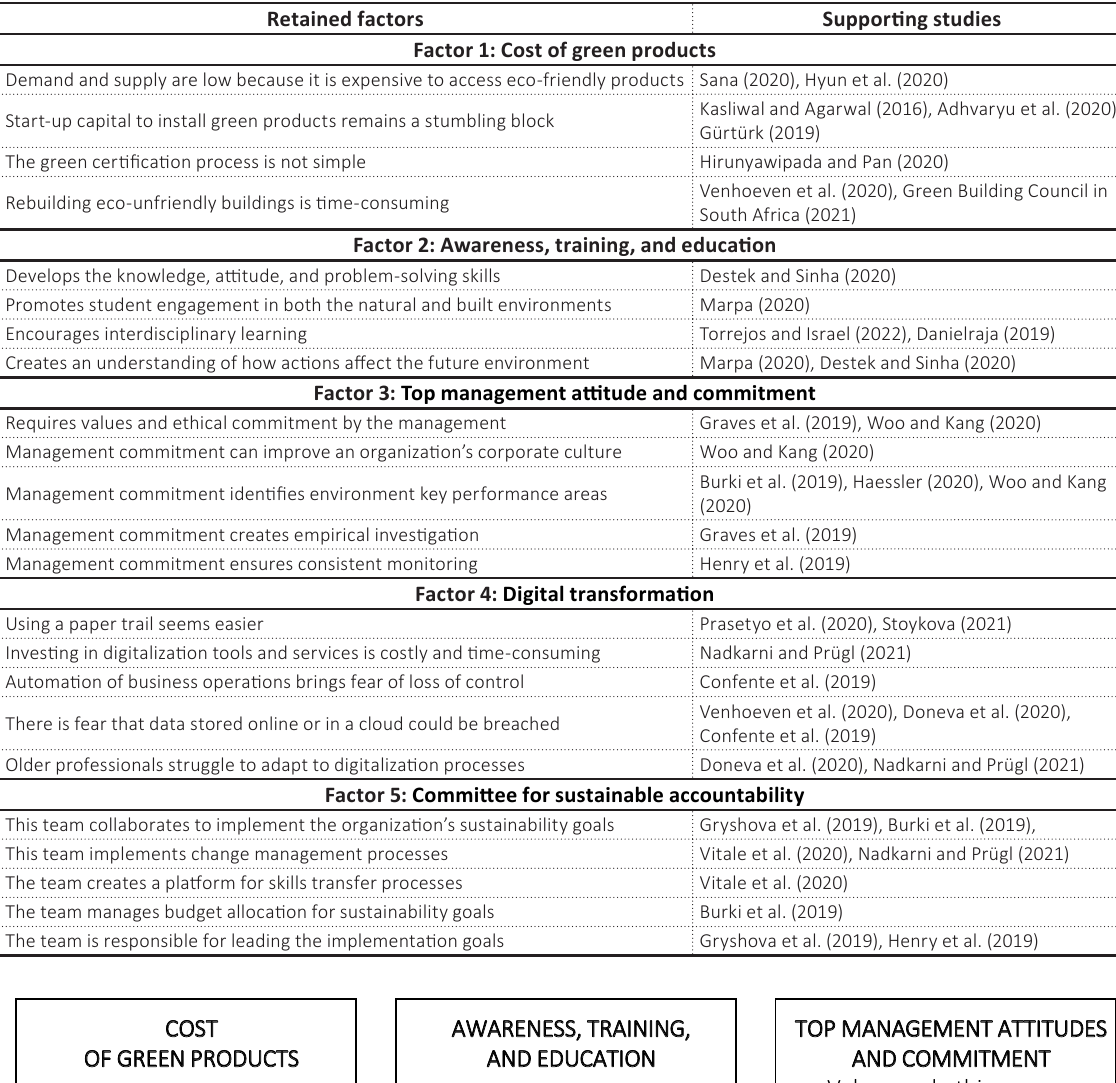
Table 2. Measuring criteria and theoretical support Retained factors Supporting studies Factor 1: Cost of green products